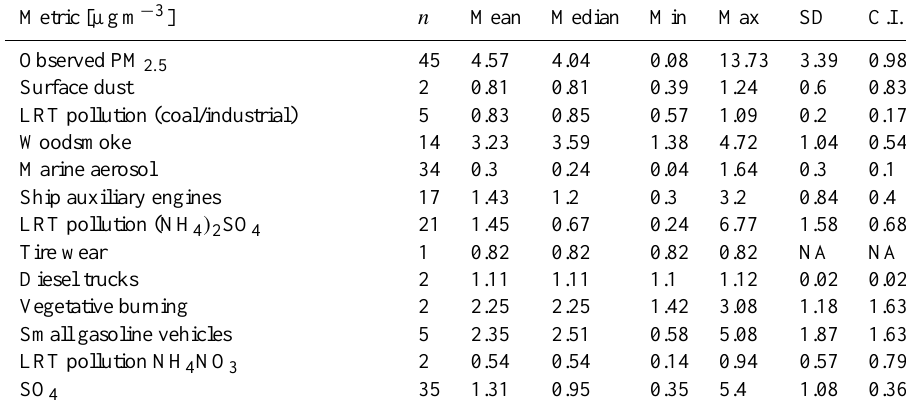
Table 5. Chemical mass balance PM 2 . 5 source apportionment descriptive statistics.